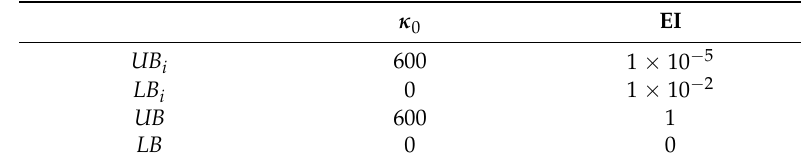
Table 4. Upper and lower parameter bounds for the initial population ( UB i and LB i , respectively) and subsequent populations ( UB and LB ).